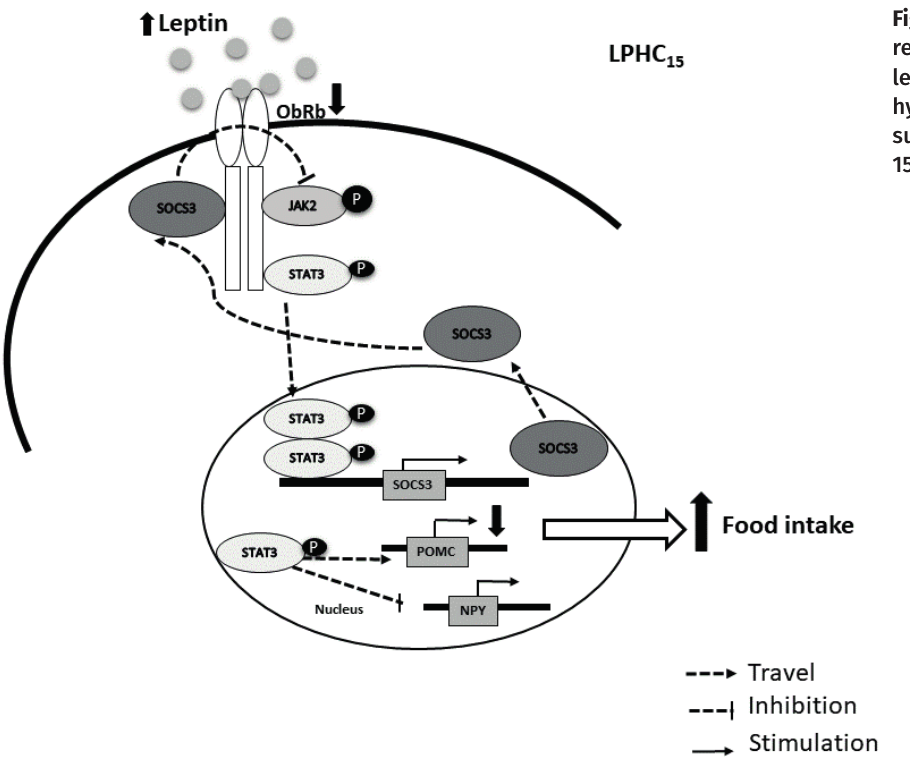
Figure 5. Schematic representation of leptin signaling in the hypothalamus of rats subjected to LPHC diet for 15